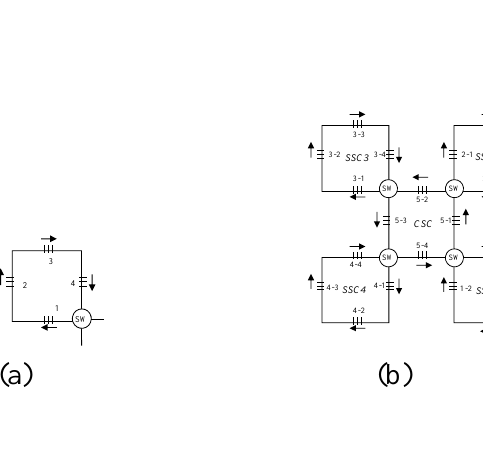
Figure 2. (a) SSC; (b) SSC group; (c)